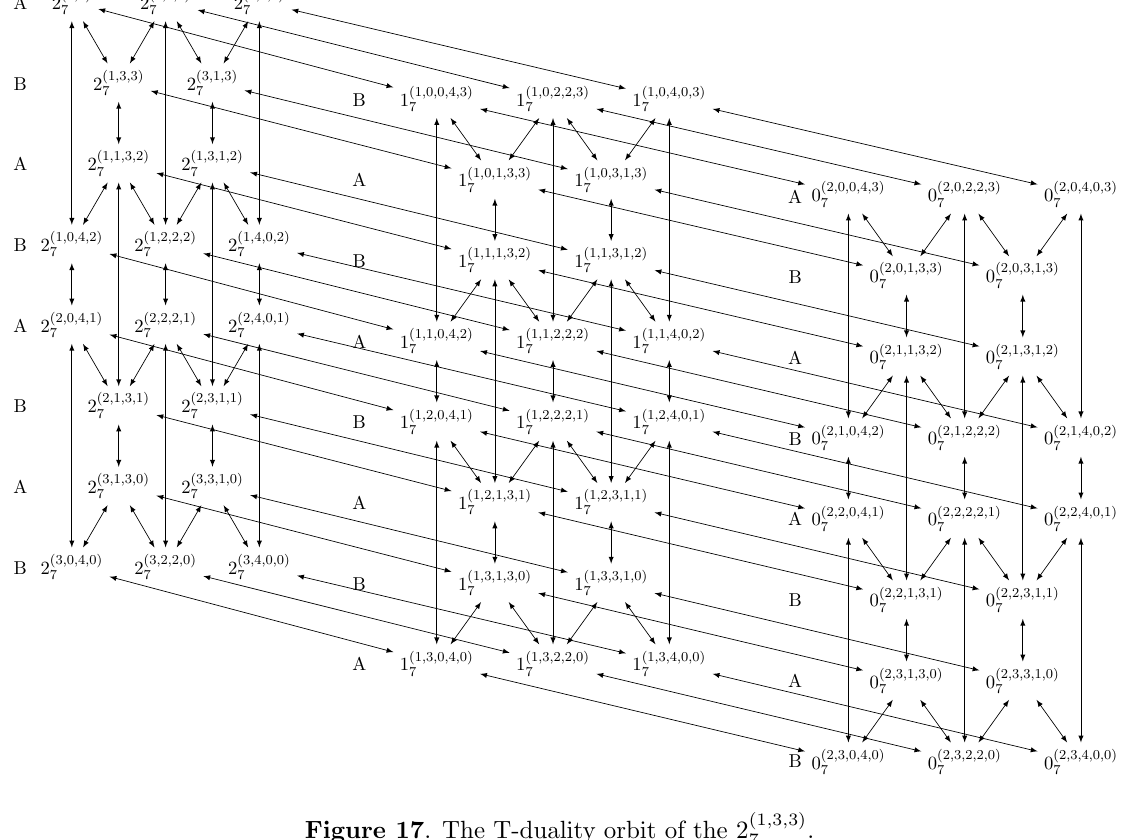
Figure 17 . The T-duality orbit of the 2 (1 ; 3 ; 3)